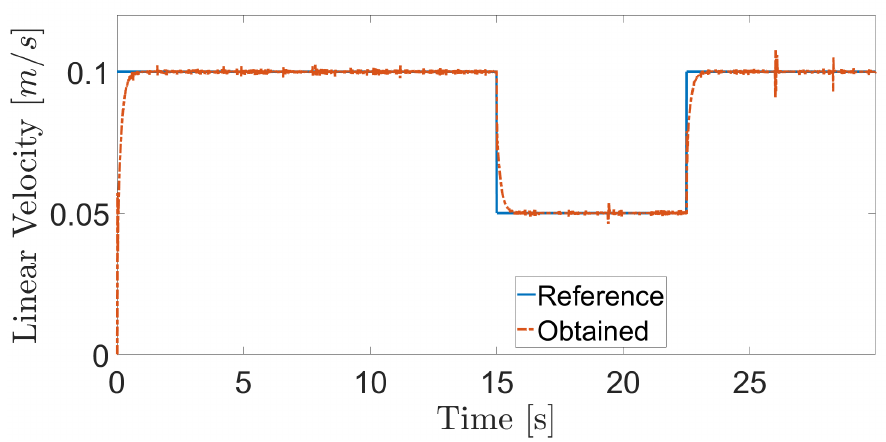
Figure 12. Linear velocity in the PI controller during navigation of the climbing robot in the storage